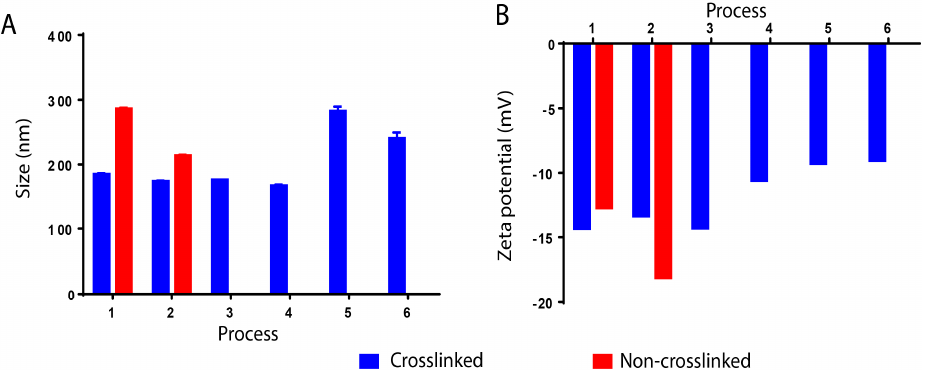
Figure 14. The effect of process variation on the size and zeta potential values of BSA nanoparticles. Measurements from separate assays were combined ( n = 6) and expressed as mean ± SD.